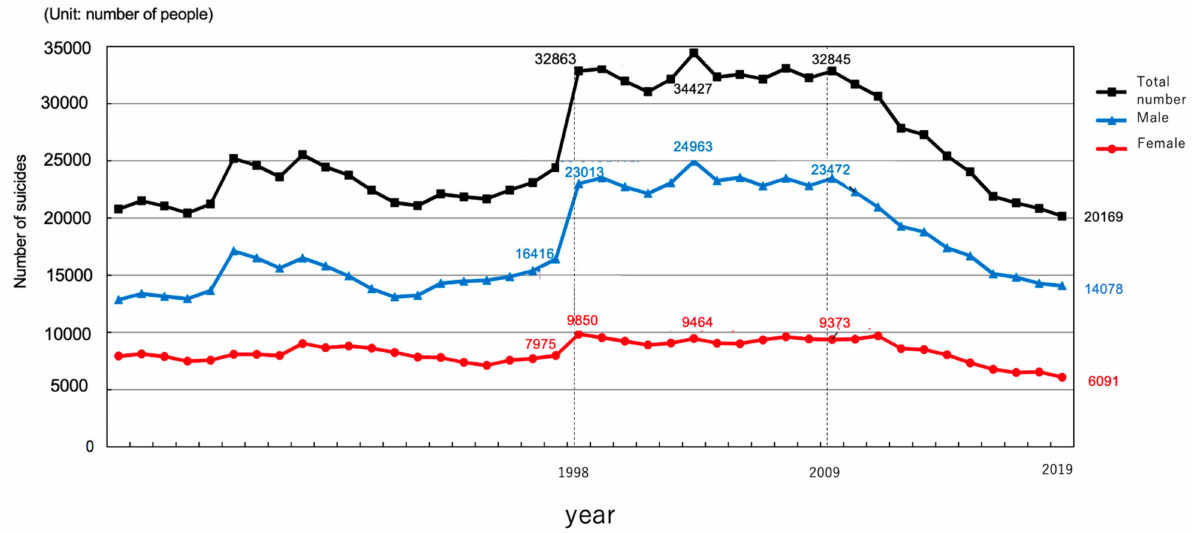
Figure 2. Annual change in the number of suicides in Japan from 1998 to